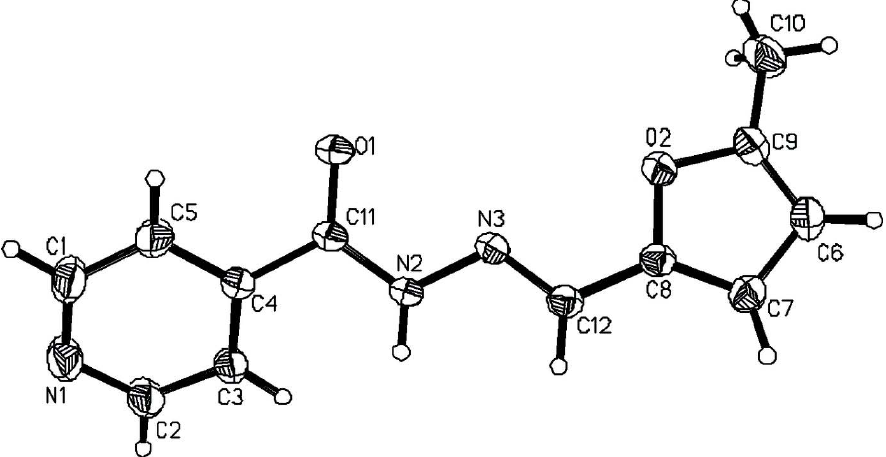
Figure 1 The molecular structure of (I) showing 30% probability displacement ellipsoids and the atom-numbering